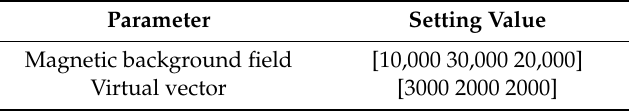
Table 1. The setting value of magnetic background field.